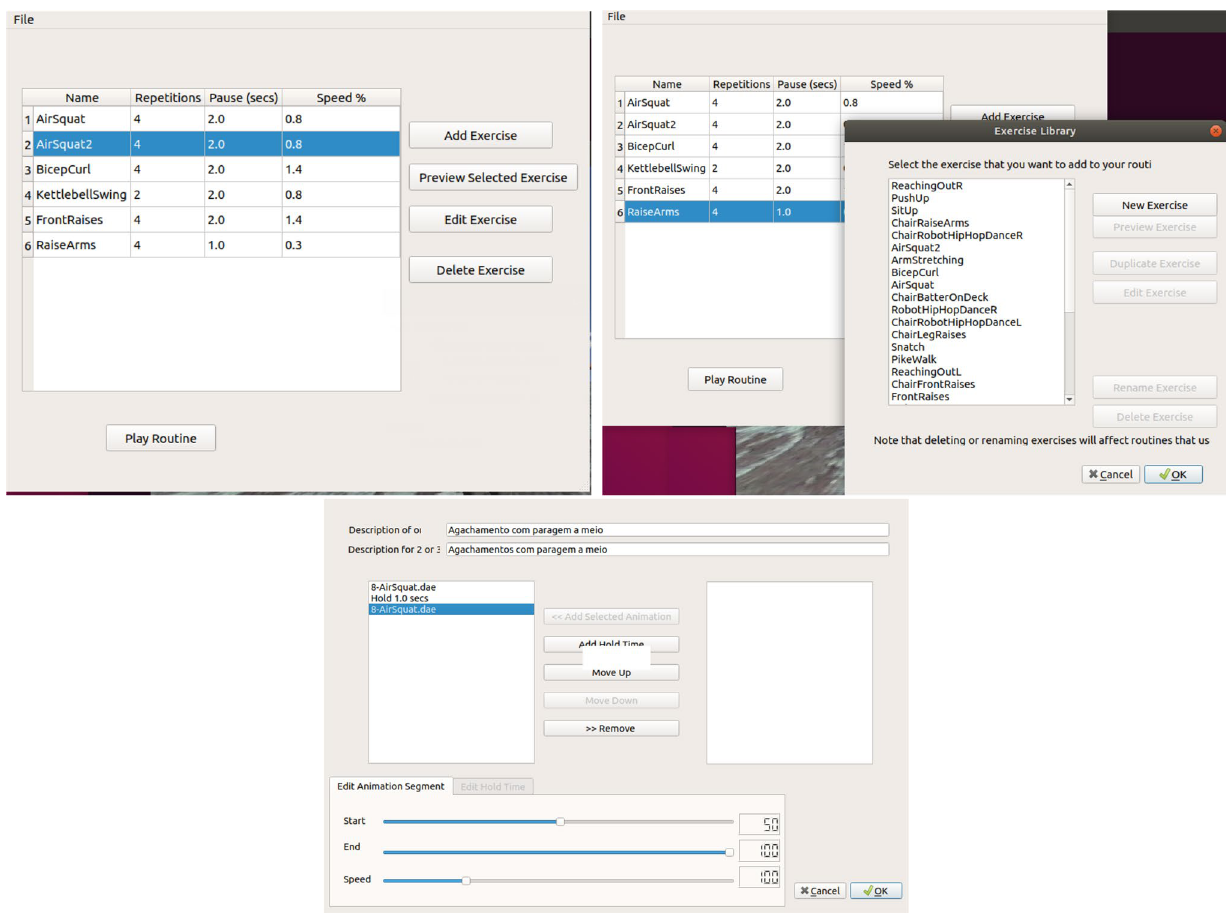
Fig. 1 Exercise Routine Designer editing windows: editing the number of repetitions, pause length, and speed factor (top left); adding a new exercise to the routine from the current list (top right); definition of a new exercise from parts of exercises (bottom)